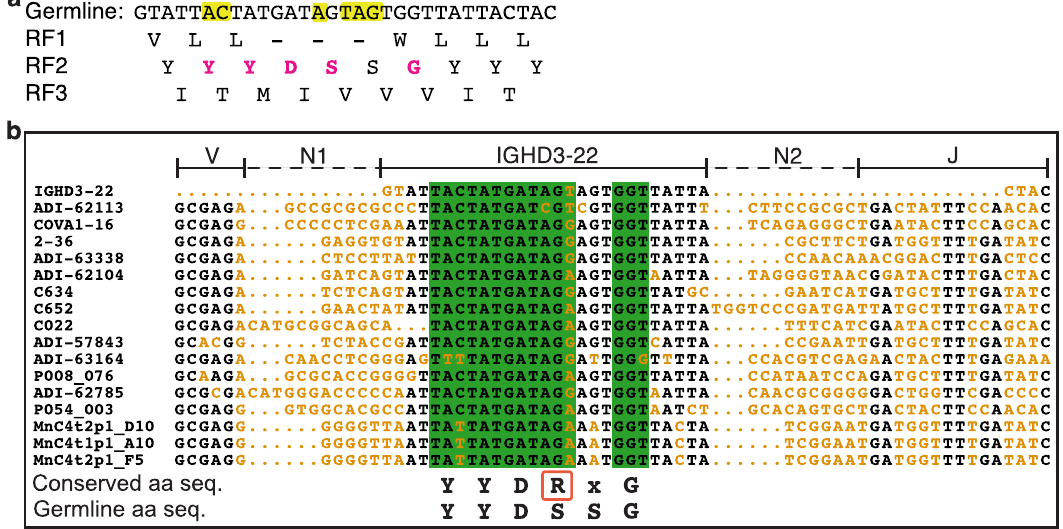
Fig. 4 Reading frames (RFs) and sequence alignment of IGHD3-22 . a Three possible RFs of the IGHD3-22 germline sequence were translated into amino- acid sequences. Only RF2 encodes the YYDRxG motif (magenta). Nucleotides highlighted in yellow in the germline DNA sequence indicate sites where somatic hypermutations are often found in YYDRxG neutralizing antibodies against SARS-CoV-2. – indicates a stop codon. b Alignment of YYDRxG coding sequences in CDR H3. Conserved nucleotide sequences are in black, and variable sequences in orange. N additions (N1 and N2) as de fi ned by IMGT junction analysis 75 are indicated by dashed lines. IGHD3-22 , IGHV(V), and IGHJ (J) regions are indicated by solid lines above the sequences. Sequences in a green background encode the YYDRxG key residues. Conserved YYDRxG sequence and corresponding germline amino-acid sequence (aa seq.) are shown below the sequence alignment panel for comparison. The arginine residue in the YYDRxG motif in a red box resulted from a high co-incidence of somatic mutations. Only the fi rst 16 coding sequences are shown in the sequence alignment to represent 100 such antibodies against